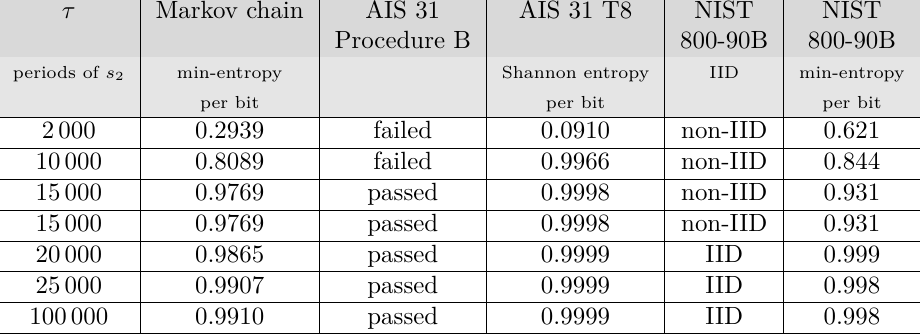
Table 7: Entropy estimation using high order Markov chains, AIS 31 and NIST 800-90B tests, when two internal ROs and the least significant bits of counter values were used. Dependencies are modeled using 8 th order Markov chains.